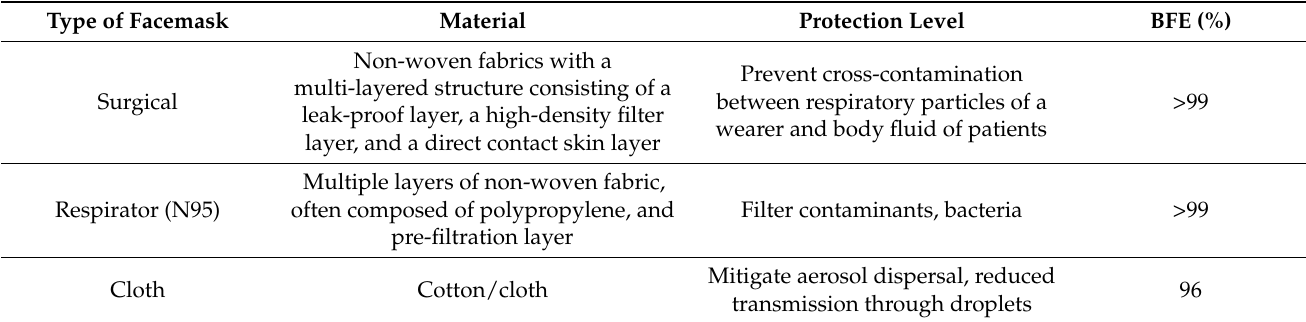
Table 1. Materials and protection level for different types of face